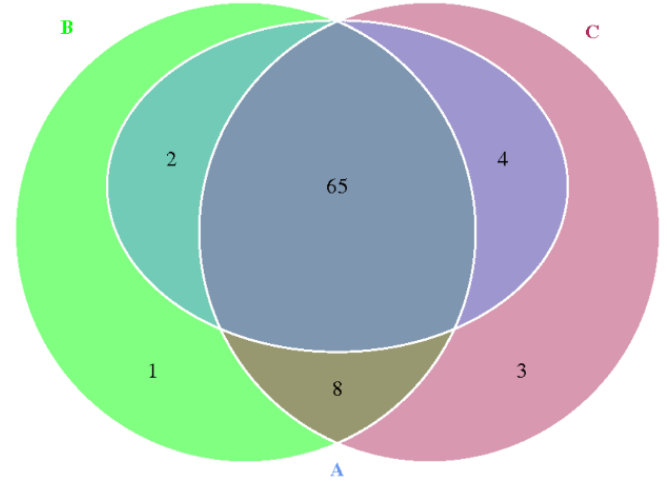
Figure 5. Venn diagram showing the number of shared and unique ARG subtypes among fermented suancai samples.